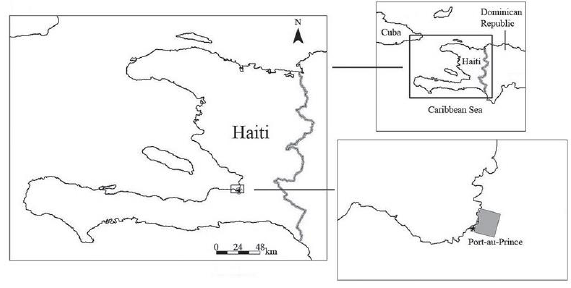
Figure 3. Location map of the study